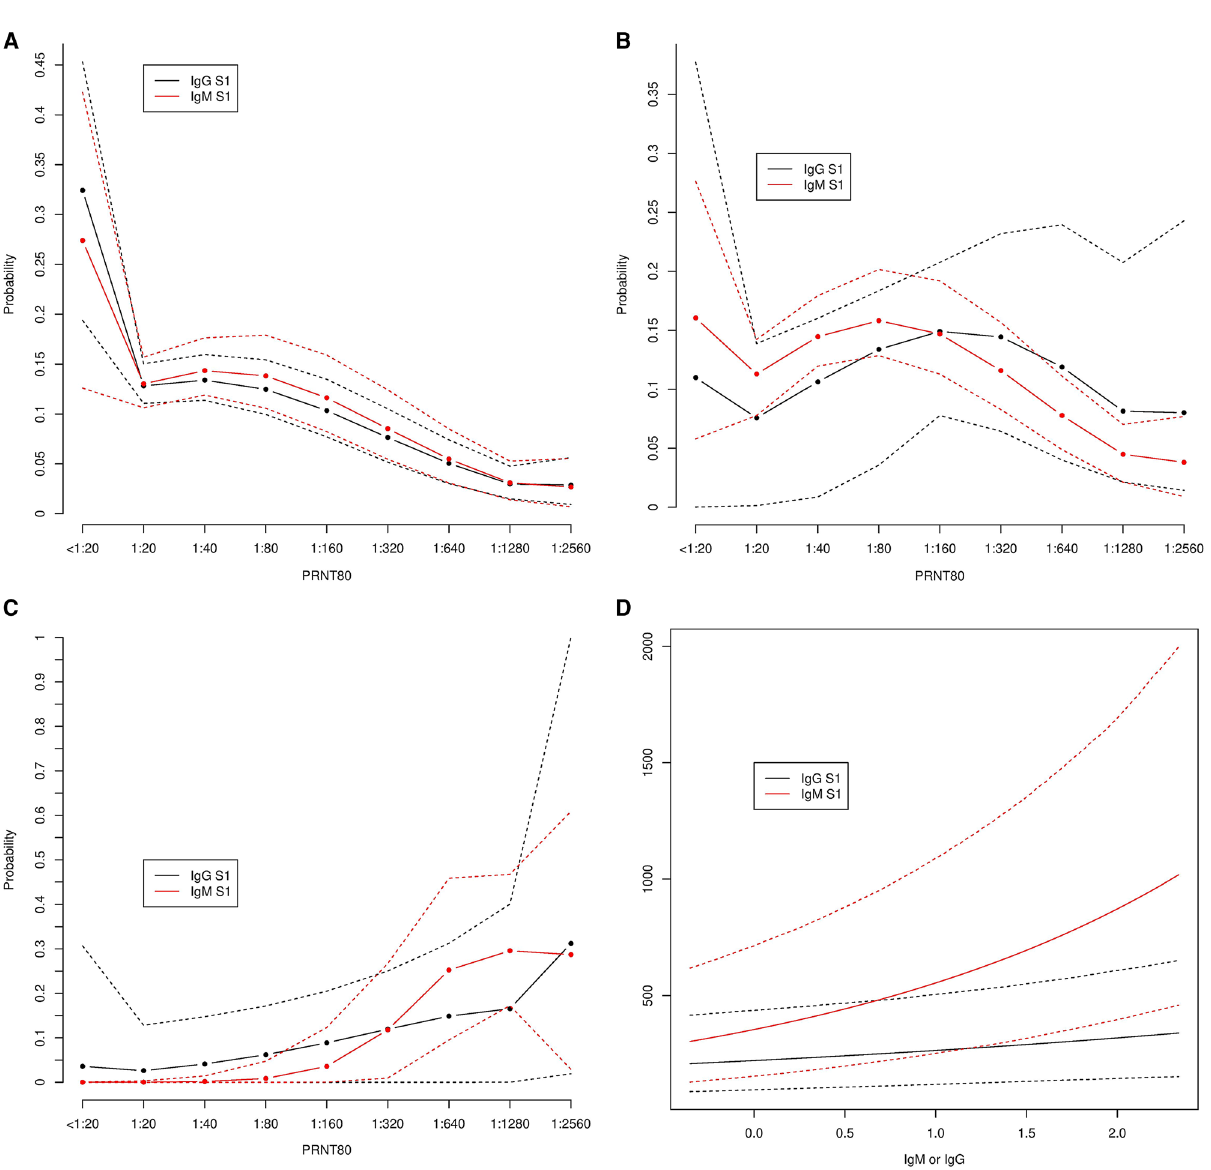
Figure 2. PRNT 80 probability estimates of PRNT 80 for first quartile ( A ); median ( B ); and third quartile IgG and IgM S1-RBD ELISA results ( C ). ( D ) shows predicted PRNT 80 (NAb) by IgG or IgM S1-RBD ELISA